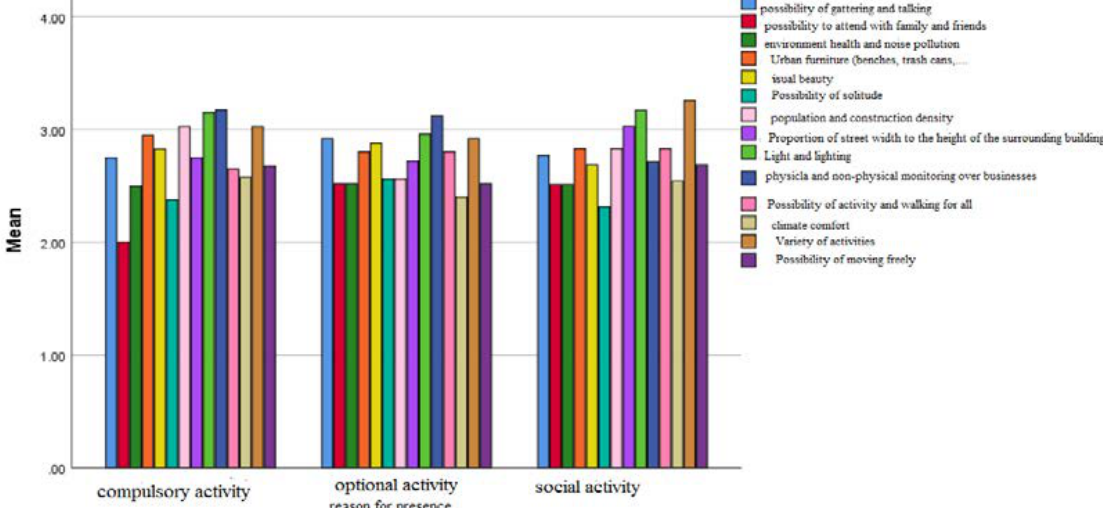
Fig . 8: Diagram of the difference between the independent groups in the Kruskal-Wallis test Fig. 8: Diagram of the difference between the independent groups in the Kruskal‐Wallis test